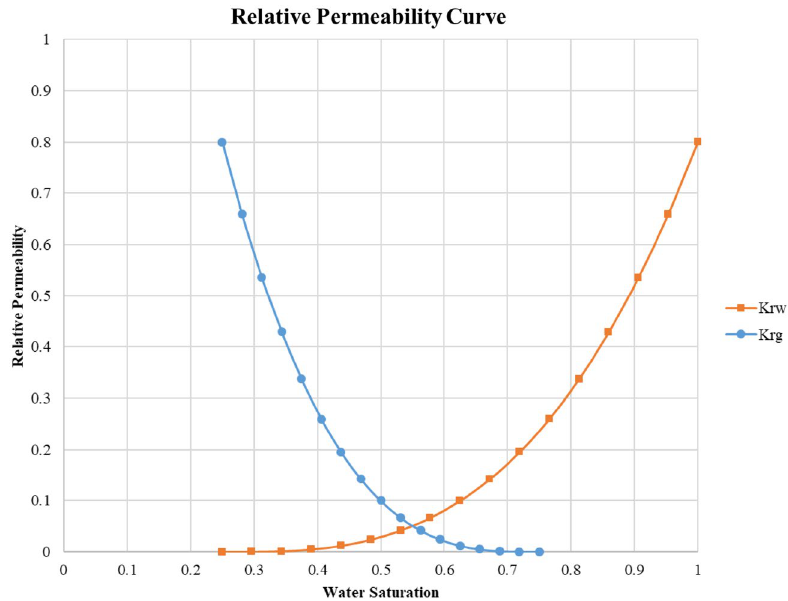
Fig. 4 General fluid relative permeability curve to be applied in model